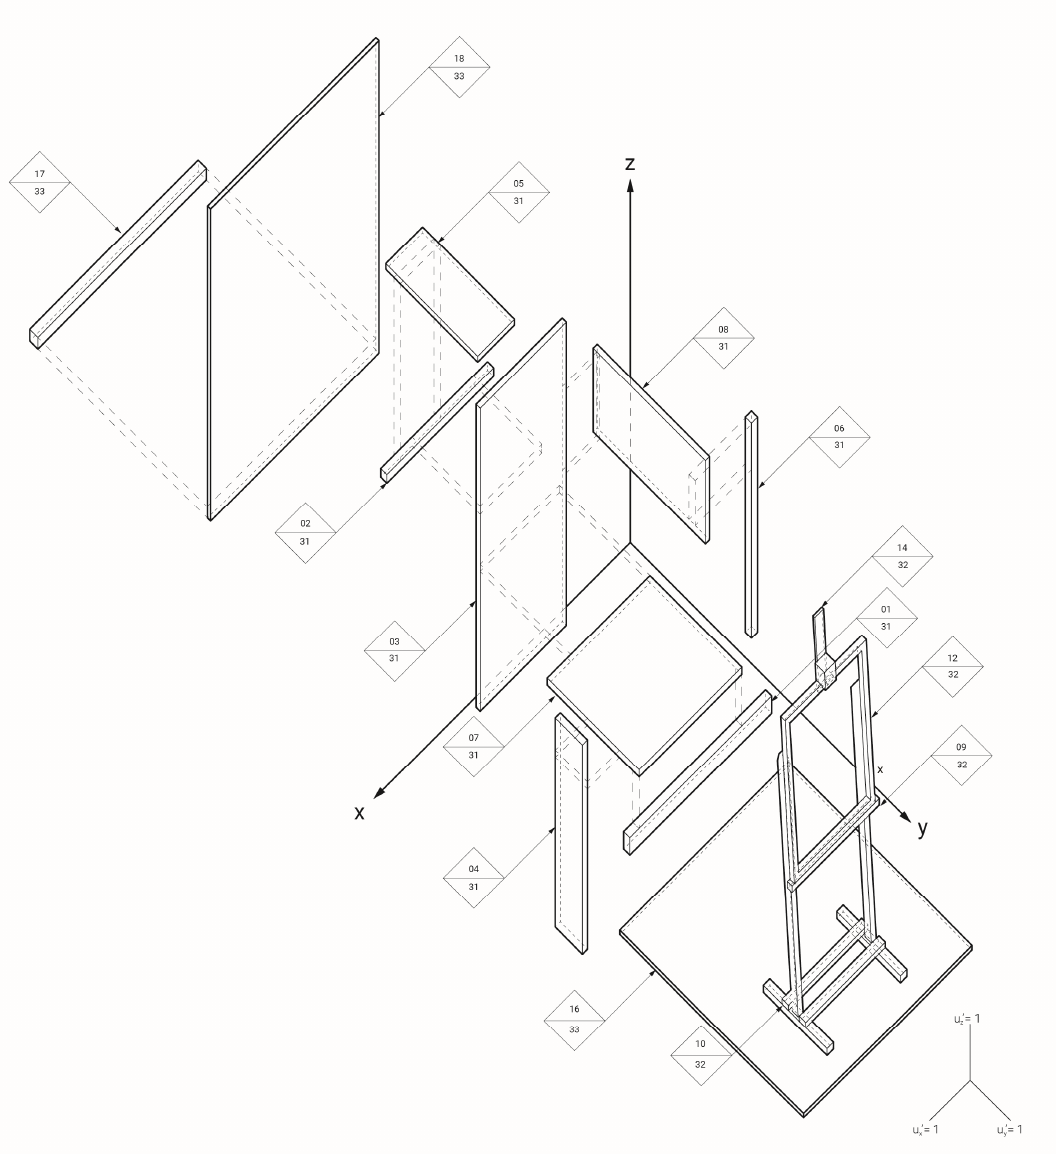
Figure 6. Maria Virgilia Manzoni, Annalisa Marchetti: “ Hypertime